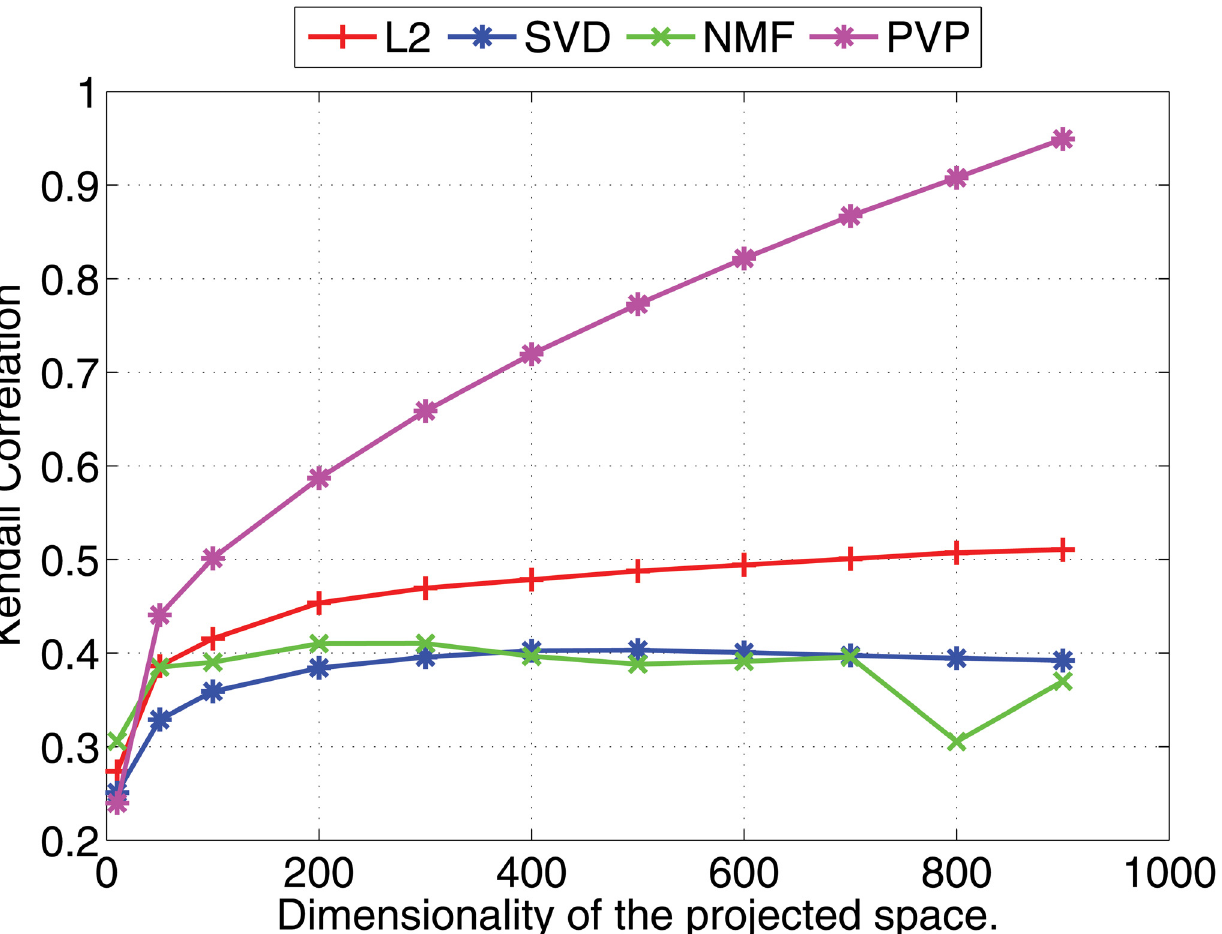
Fig 6. Nearest neighbor prediction with English feature vectors. Kendall ’ s τ (right) correlation coefficients for different dimensionality reduction methods are shown under varying dimensionalities (Feature vectors are 1000 dimensional).